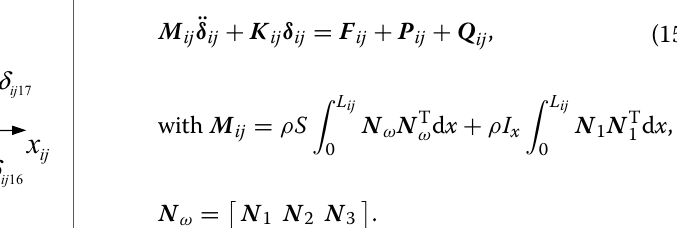
Figure 6 Spatial beam element